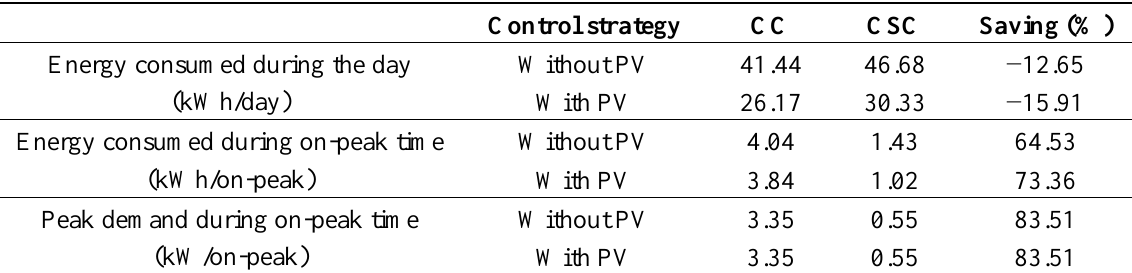
Table 7. Comparison of electricity consumption and peak demand for two test days using conventional and peak reduction control strategies in space-heating-mode tests (CSC in space heating